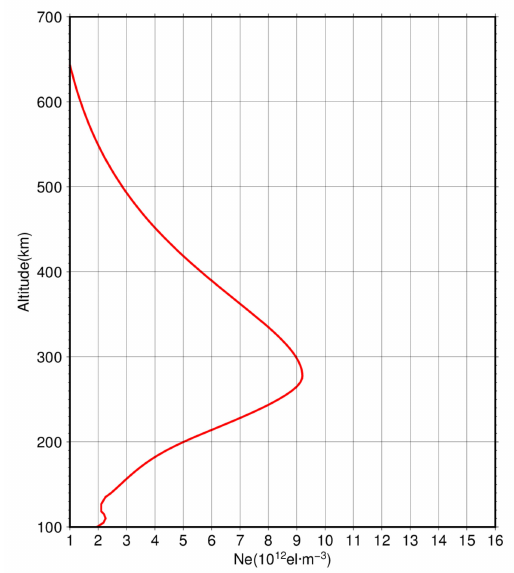
Figure 14. Electronic density profile (Zuoling station) at 0:00 UTC, 20 April 2013.